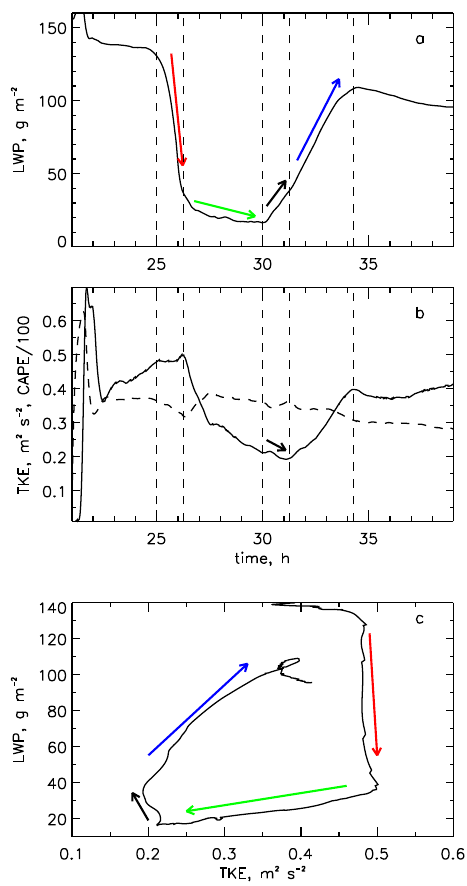
Figure 7. Analysis of RRTM simulation and minimum N = 5mg − 1 (solid line, Fig. 6b). Time series of (a) domain mean LWP and (b) TKE averaged horizontally, over the boundary-layer depth (solid line), and CAPE (dashed line); (c) a phase diagram of (a) vs. (b) . Colored arrows indicate stages of evolution of the system. Vertical dashed lines are included to focus on temporal phase lags between LWP and TKE. Red arrow: LWP falls rapidly while TKE continues to increase; green arrow: both LWP and TKE decrease; black arrow: LWP begins to recover while TKE still decreases; blue arrow: LWP and TKE increase in unison as the closed-cell state recovers. For t > 24h, subtract 24 to get local